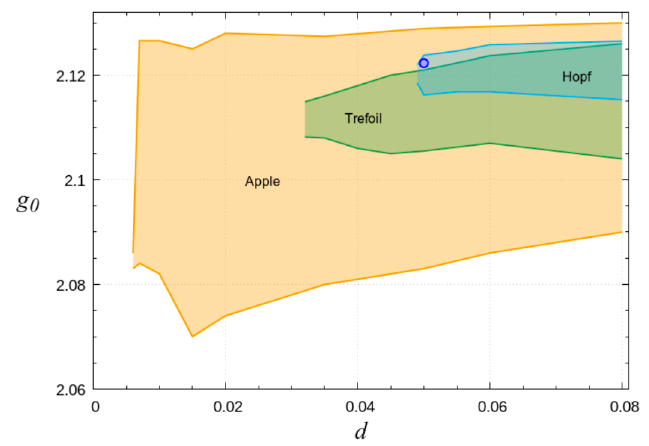
Figure 14. Domains of stability of three types of tangle laser solitons: “apple”, “Hopf + ”, and “trefoil + ”. The domains overlap; those for “Hopf + ” and “trefoil + ” are inside the widest domain of “apple” solitons.